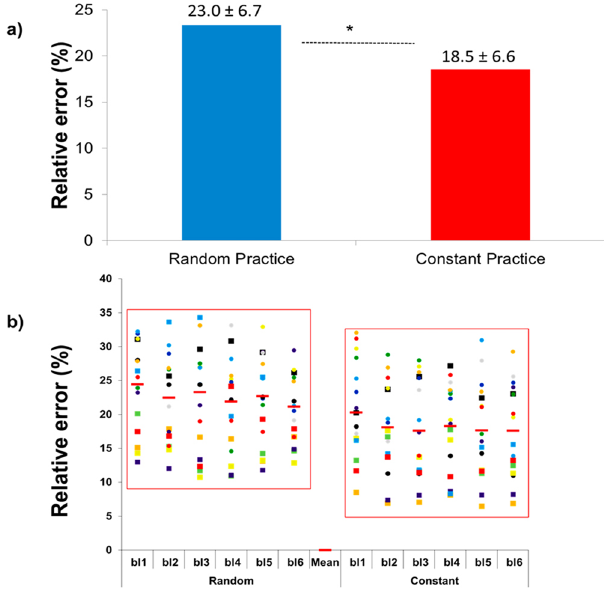
Figure 1. Relative error: ( a ) means of the relative error in the random and constant practice conditions, and ( b ) inter-subject variability over the blocks of trials (bl1…bl6) during both the random and constant practice conditions (*represents significant difference).